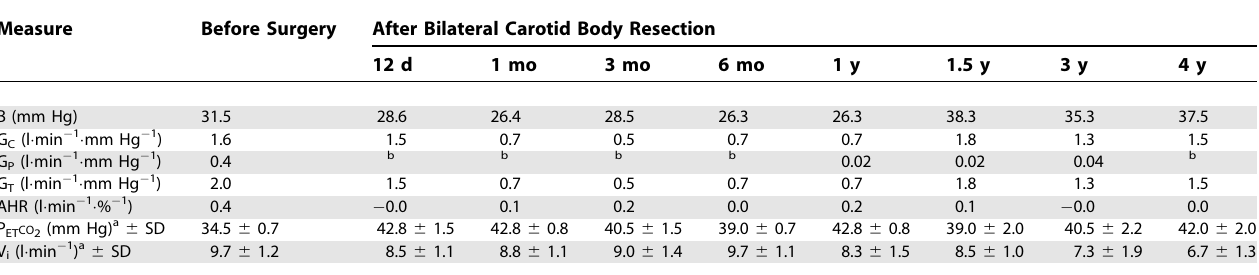
Table 3. Resting Variables and Parameters Obtained from the CO 2 and Hypoxic Challenges of Patient 1 over Time Measure Before Surgery After Bilateral Carotid Body